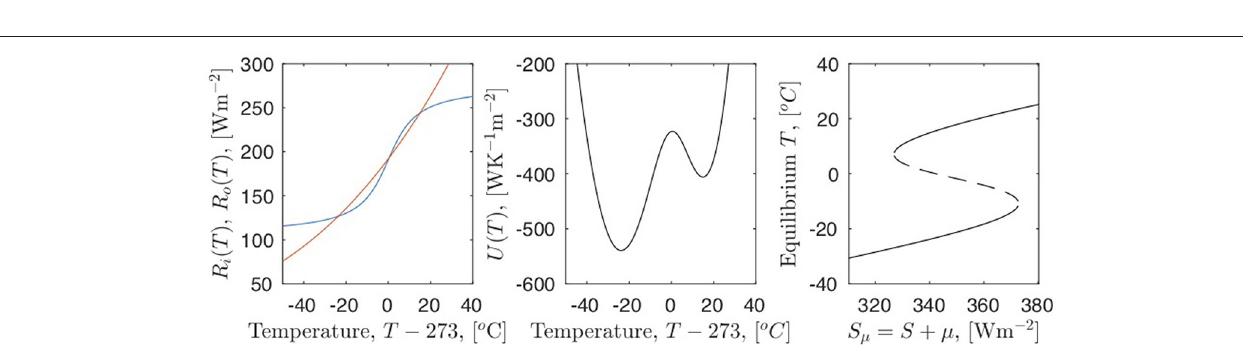
Frontiers in Physics |